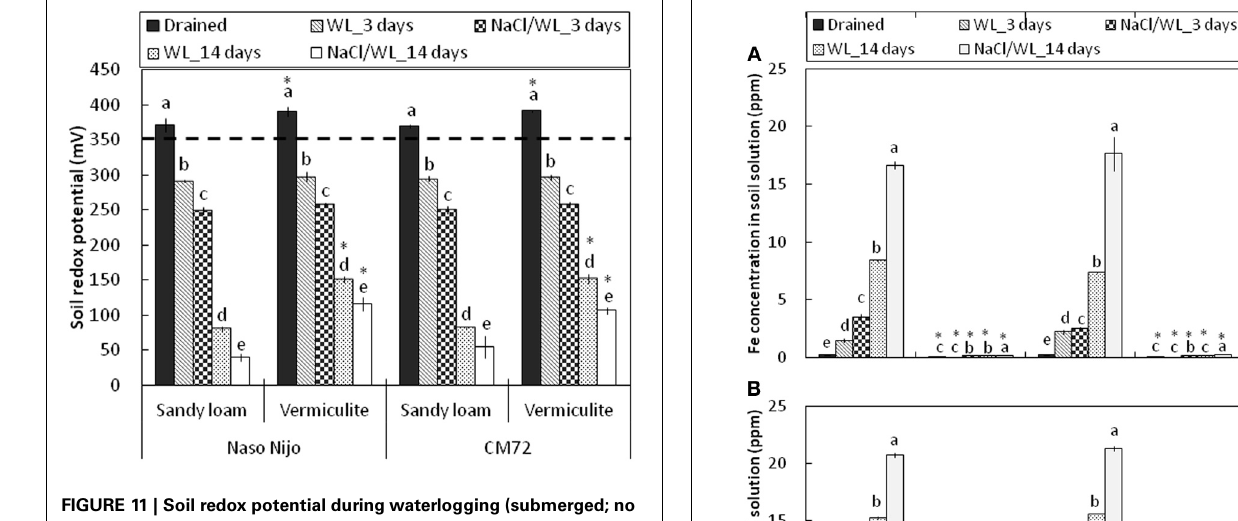
FIGURE 11 | Soil redox potential during waterlogging (submerged; no NaCl) and combined salinity and waterlogging (submerged in 200mM NaCl solution) treatments. Soil redox potential measurements were taken before treatment (drained), and 3 days and 14 days after commencing the treatments. Mean ± SD ( n = 5). Different lower case letters indicate the significant difference between treatments within soil type at P < 0 . 01. Asterisk indicates the significant differences between sandy loam and vermiculite within variety a P < 0 . 01. Horizontal dashed line indicates the threshold level for anaerobic condition (below 350mV).